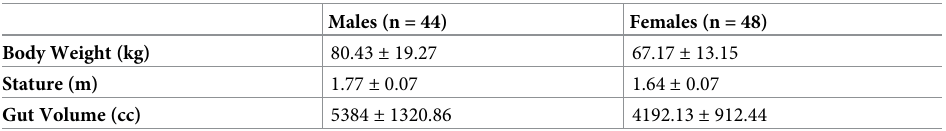
Table 1. Descriptive statistics for study